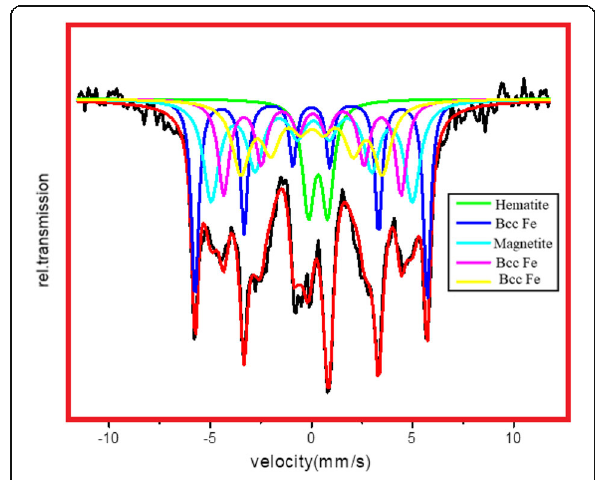
Fig. 9 Mössbauer spectra of Fe NCs-0 at 320 K